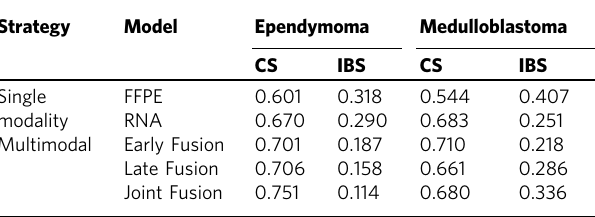
Table 3 Transfer learning results of pediatric glioma models on ependymoma and medulloblastoma pediatric